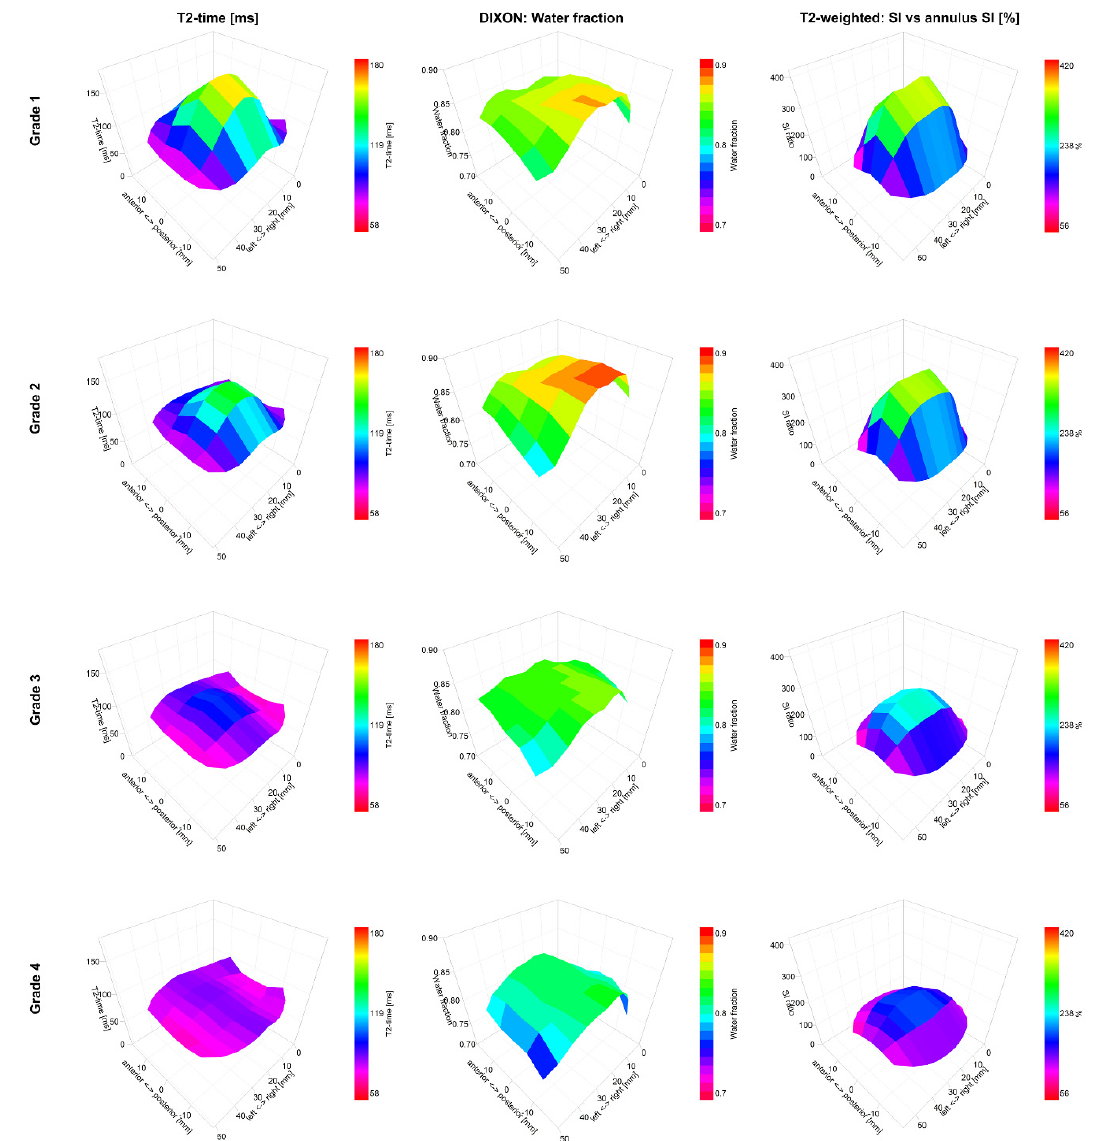
Figure 3. Graphical representations of the IVDs in terms of 3D plots for T2-mapping, T2w imaging and Dixon imaging. Values are averaged across each Pfirrmann grade for all IVDs, T12 / L1 to L5 / S1 (606 IVDs from 101 subjects). Color keys indicate range of values.